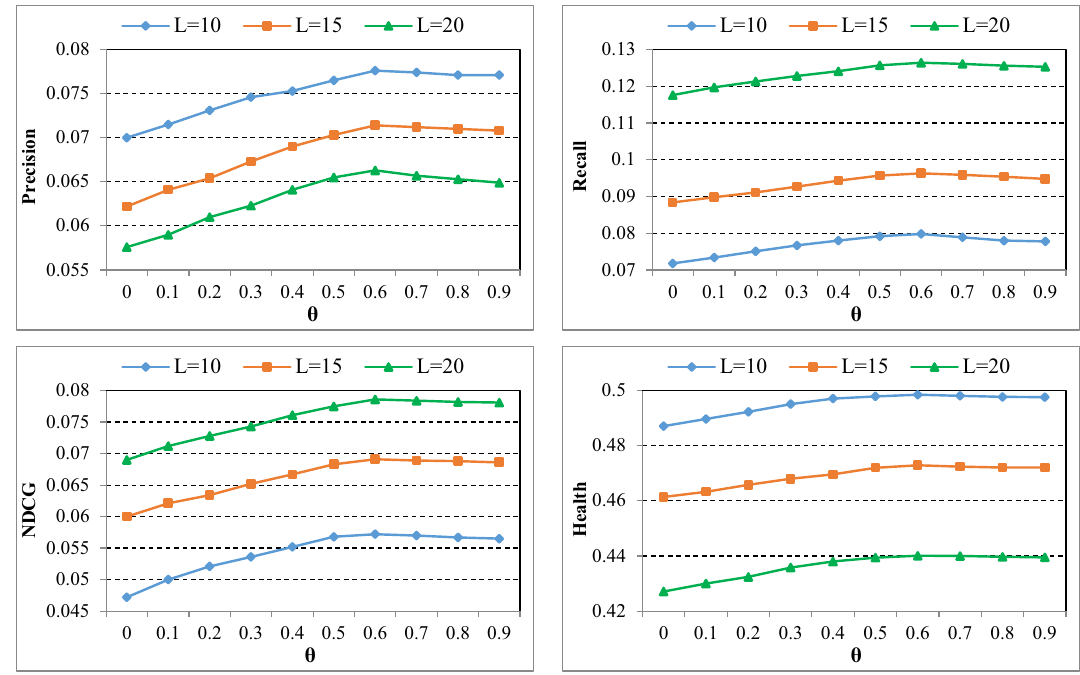
Fig. 3 Experimental results regarding the sensitivity analysis of the parameter